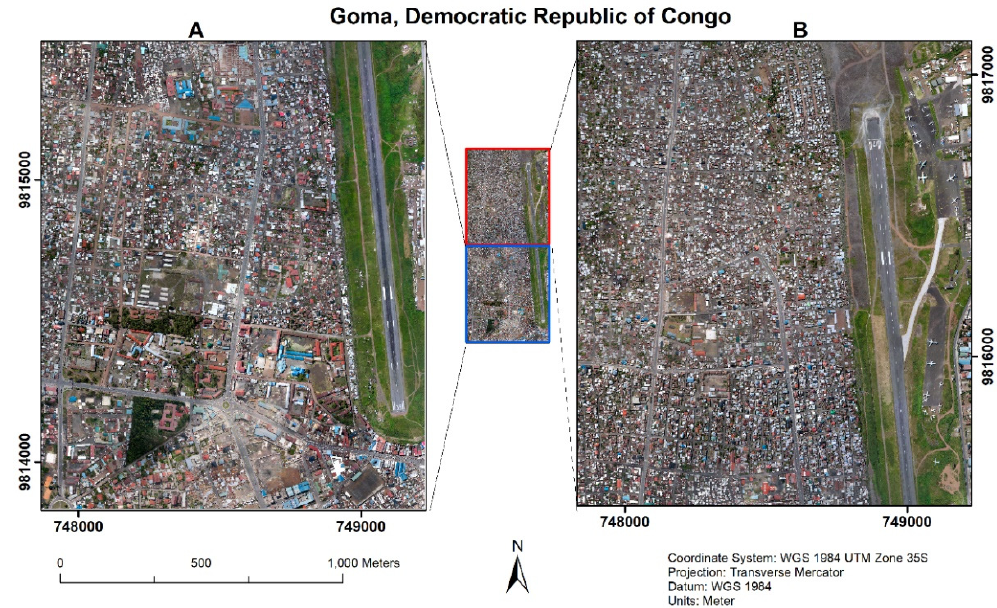
Figure 1. Map illustrating the study area of Goma, Democratic Republic of Congo. The training and testing data are generated from Tile A and Tile B respectively. The images have been provided by the Royal Museum for Central Africa (RMCA), Belgium.